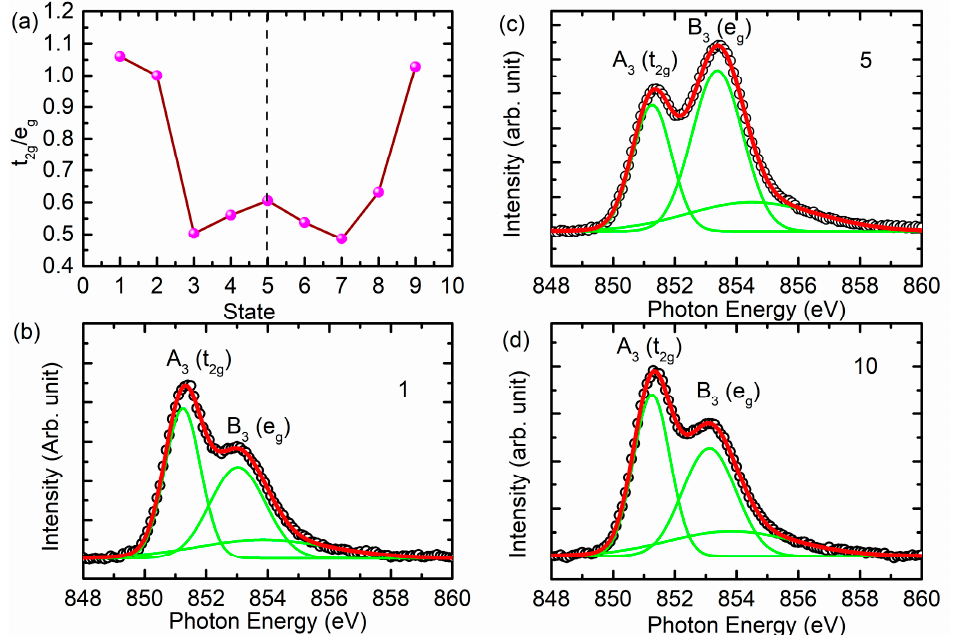
Figure 7. ( a ) The t 2g / e g ratio estimated from the Ni L -edge spectra at various stages of charging and discharging. Here, ( b ), ( c ), and ( d ) show the representative de-convoluted spectra for states 1, 5, and 9.